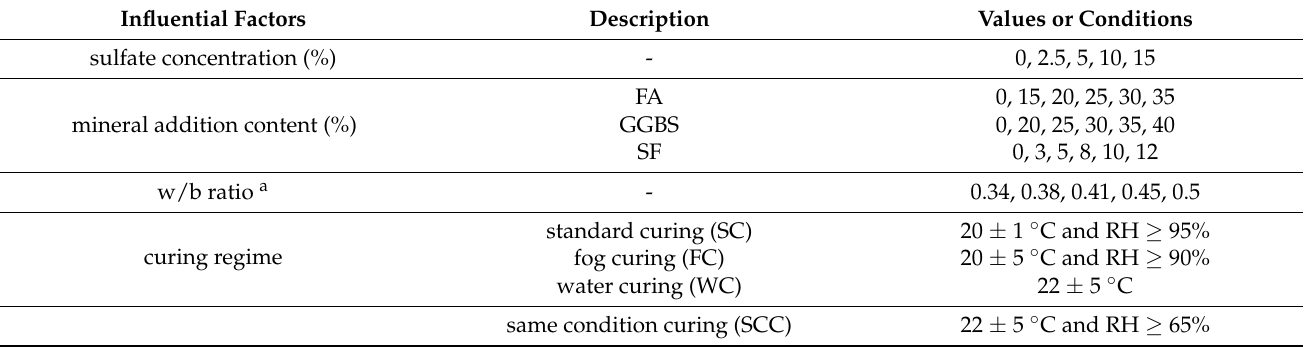
Table 6. Test design of different influential factors.